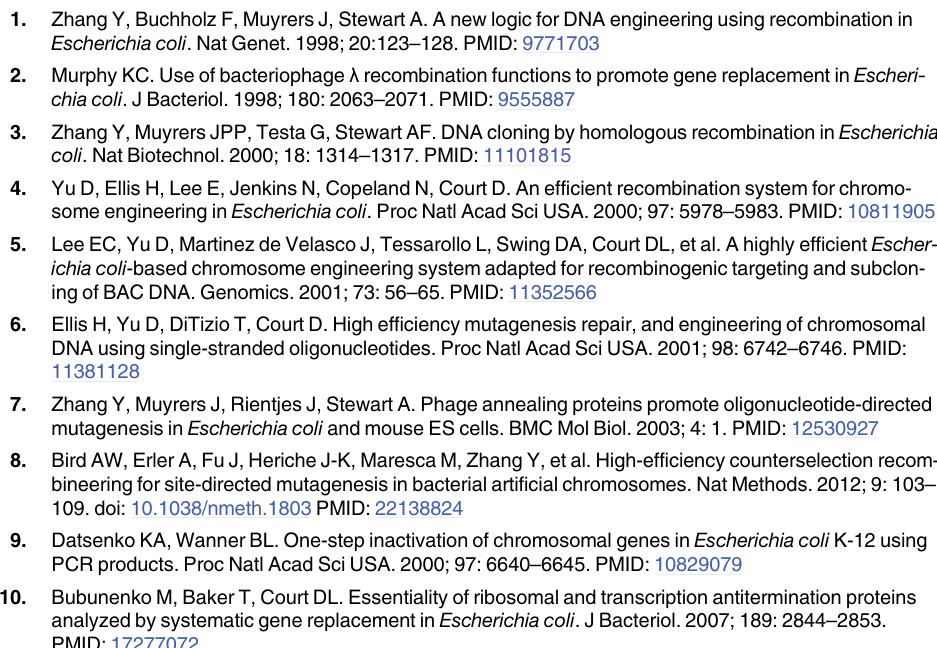
P2rx1 and Camkk genes. Arrow indicates the direction of replication fork movement. (TIF) S2 Fig. Effect of homology length on SPI using two different insertion cassettes. A SPI assay was performed at the P2rx1 gene using a p15A dhfrII lagging strand protected subcloning plas- mid containing 230 bp homology regions and a homology series (20 bp, 35 bp, 60 bp, 90 bp, 120 bp and 180 bp) of two different Gentamicin and Zeocin lagging strand protected cassettes both containing the same HL. Data points represent averages; error bars indicate standard error of mean ( n = 3). (TIF) S3 Fig. SPI assay using different homology combinations of subcloning plasmid and inser- tion cassette. SPI was performed at the P2rx1 gene using lagging strand protected cassettes and plasmids in combination as shown in the table. Values represent averages; error bars indi- cate standard error of mean ( n = 3). S1 Table. Recombination frequencies of the different assays. S2 Table. Insertion cassettes, subcloning plasmids and oligos used in this